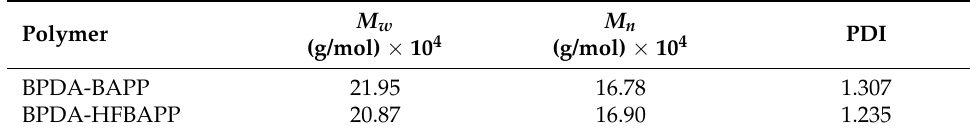
Table 1. Molecular weight and PDI of synthesized polyamic acid.